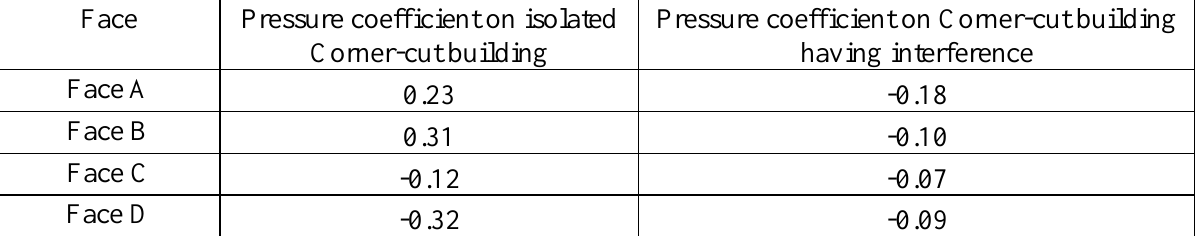
Mean pressure coefficient on corner-cut building, with and without interference at 45° wind incidence angle.